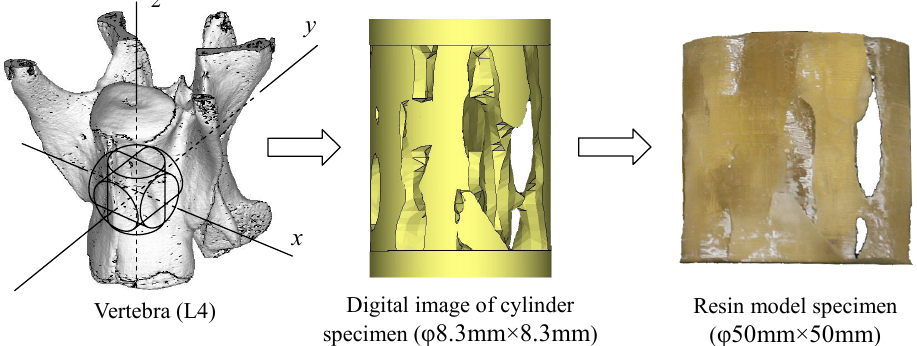
Fig. 2 Bone model specimen preparation protocol. Cylinder images ( φ 0.83 mm×0.83 mm) were extracted from the one vertebral STL data along anatomical axes in the craniocaudal ( z -axis), mediolateral ( x -axis), and anteroposterior ( y -axis) axes. Bone model specimens ( φ 50 mm×50 mm) were fabricated at 60 × magnification from the cylinder